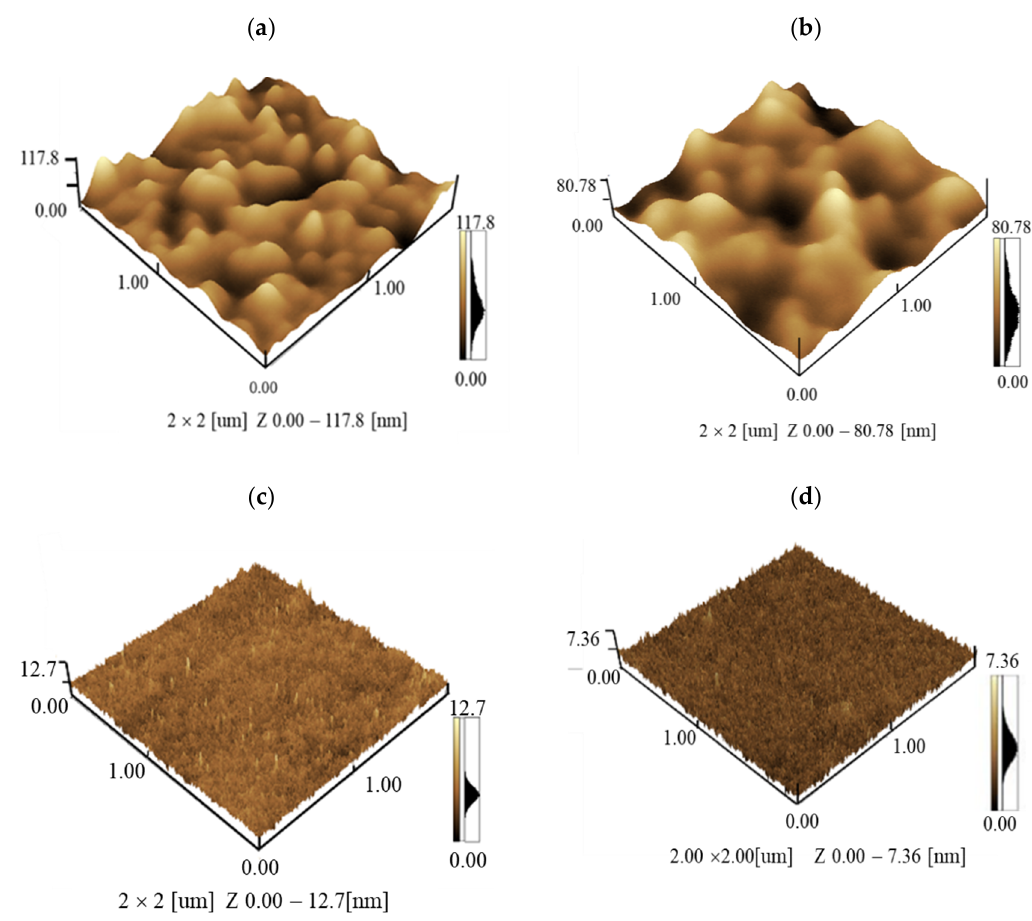
Figure 2. Three-dimensional-AFM images of the heat-treated films on two different glass substrates fabricated via the ESD and spin-coating processes: ( a ) FTOESD; ( b ) FTOSPIN; ( c ) QCNTESD; ( d ) QSPIN. Table 1. Surface roughness and film thickness of the heat-treated thin films on two different glass substrates prepared via the ESD and spin-coating processes, FTOESD, FTOSPIN, QCNTESD, and QSPIN.